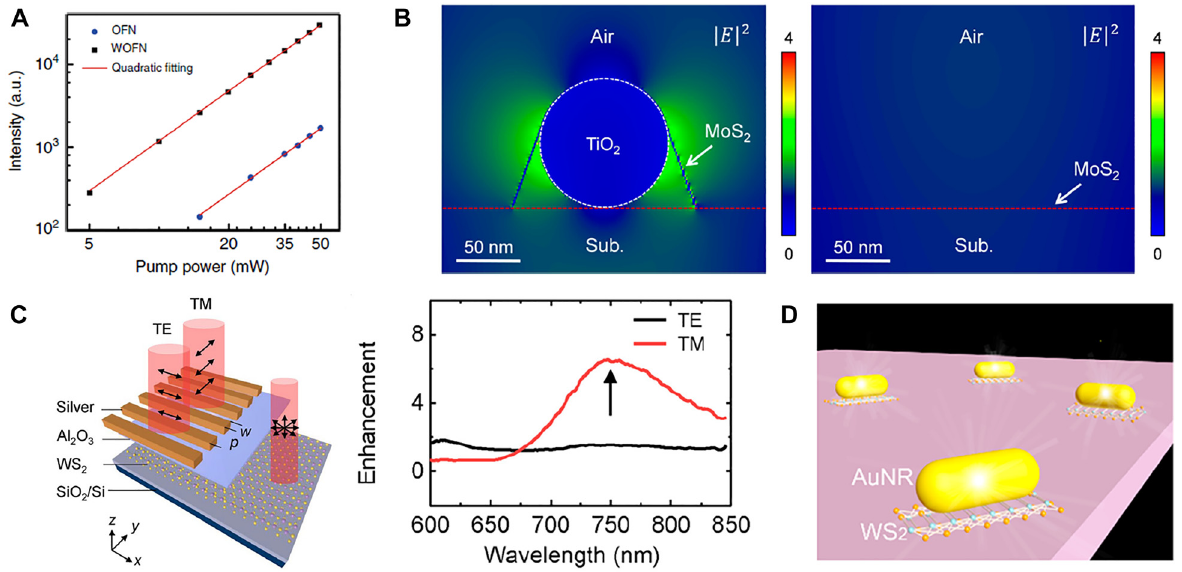
Figure 3: Hybrids of NW and 2D TMDs for the enhancement of light – matter interactions. (A) Secondharmonic generation intensity as a function of the pump power for the OFN and WOFN. Reproduced/adapted with permission from Chen et al. [26]. Copyright 2019 by the original authors(CC BY). (B) Calculated electric fi eld distribution( | E | 2 ) excited by the fundamentalwave ( λ = 800 nm) in: MoS 2 /NW hybrid (left) and pristine MoS 2 fi lm (right). Reproduced/adapted with permission from Li et al. [21]. Copyright 2019 AmericanChemicalSociety.(C)Left,schematicofthehybriddevice.Right,PLenhancementsofthehybridmaterialrelativetothepristineWS 2 for TE and TM polarizations. Reproduced/adapted with permission from Han et al. [62]. Copyright 2021 by the original authors (CC BY). (D) Schematic of the heterostructure composed of a gold nanorod integrated on top of a WS 2 monolayer. Reproduced/adapted with permission from Jiang et al. [23]. Copyright 2020 American Chemical